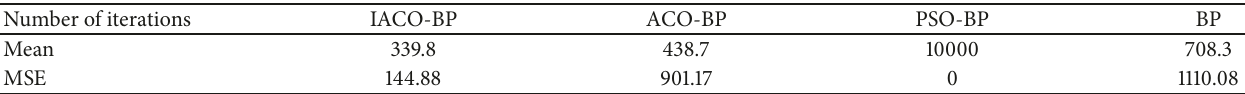
Table 6: Comparison of iterations.